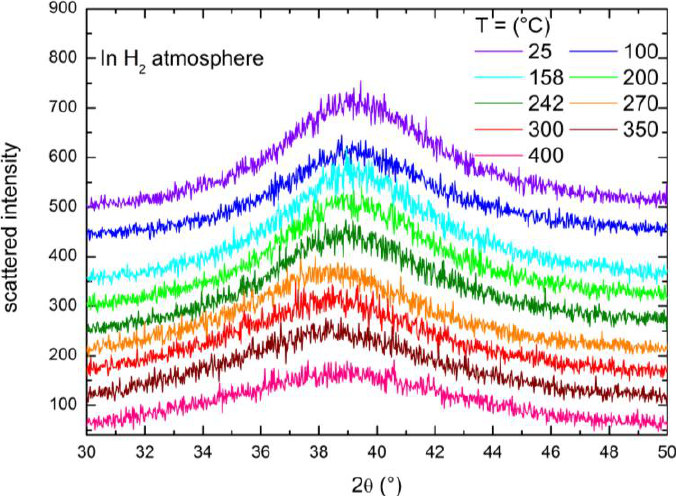
Figure 5. X-ray diffractograms measured on increasing temperature with the sample kept in a H 2 atmosphere (p ~ 9 bar).